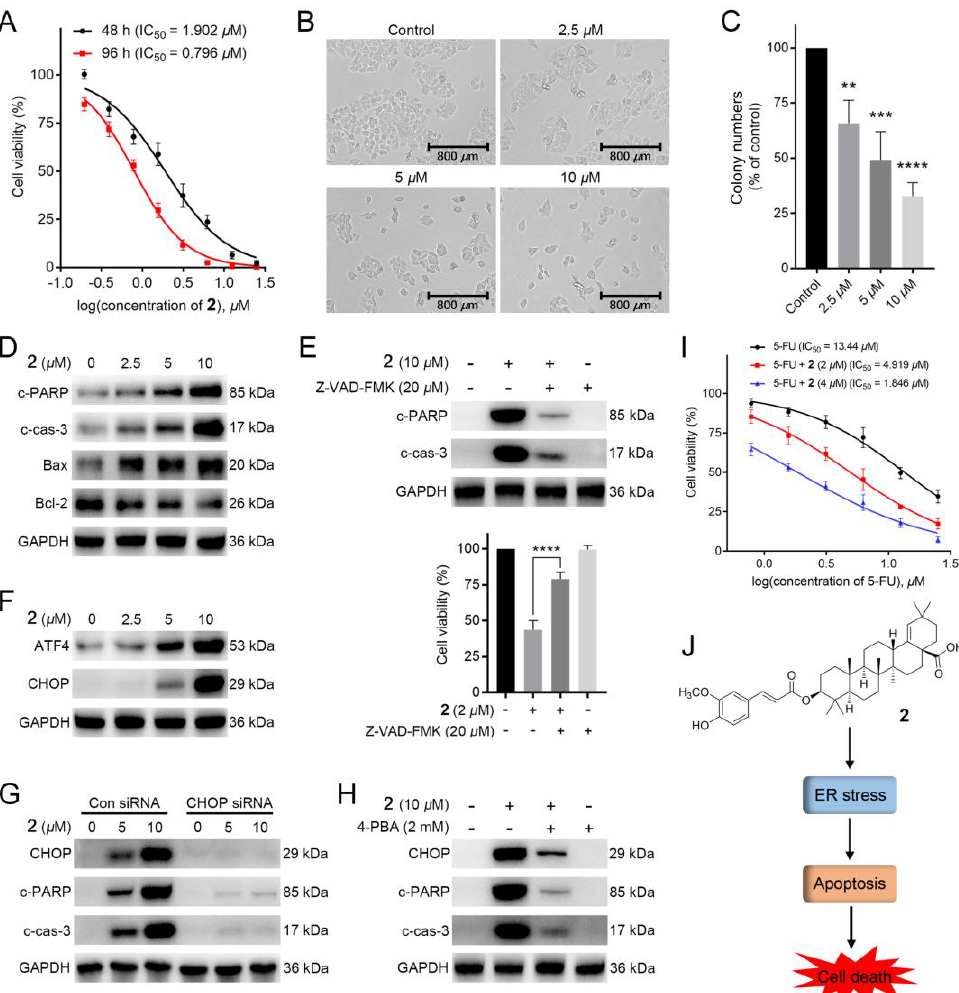
Figure 5. 2 exerted potent cytotoxic activity in colorectal cancer cells: ( A ) The anti-proliferative effects of 2 on HCT-116 cells. MTT assay was applied to determine the cell viability of HCT-116 cells treated with several concentrations of 2 for 48 and 96 h; ( B ) The cell morphology of HCT-116 cells with the administration of several concentrations (0, 2.5, 5, and 10 µ M) of 2 for 12 h; ( C ) The colony assay of HCT-116 cells with the administration of different concentrations (0, 2.5, 5, and 10 µ M) of 2 ; ( D ) Western blotting of the expressions of c-PARP, c-cas-3, Bax and Bcl-2 in HCT-116 cells. Cells were treated with or without several concentrations (2.5, 5, and 10 µ M) of 2 for 12 h; ( E ) Effects of apoptosis on 2 -induced cell death in HCT-116 cells. The expression levels of c-PARP and c-cas-3 in HCT-116 cells treated with 2 (10 µ M), Z-VAD-FMK (20 µ M), or both were measured by western blotting. MTT assay was conducted to determine the cell viability of HCT-116 cells with administration of Z-VAD-FMK (20 µ M) followed by 2 (2 µ M) for 12 h; ( F ) Western blotting analysis of key transcription factors (ATF4 and CHOP) in HCT-116 cells. Cells were added into several concentrations (0, 2.5, 5, and 10 µ M) of 2 for 12 h; ( G ) Western blotting analysis of the effect of CHOP knockdown on 2 -induced protein changes. Cells with or without CHOP knockdown were added into 2 (5 and 10 µ M) for 12h, respectively; ( H ) Western blot analysis of the effect of 4-PBA on 2 -induced proteins changes in HCT-116 cells. Cells with the pre-treatment of 4-PBA (2000 U/mL) were treated with 2 (10 µ M) for 12 h; ( I ) The anti-proliferative effects of 2 on the cytotoxicity of 5-FU in HCT-116 cells. Cells were treated with several doses of 5-FU with or without administration of 2 (2 and 4 µ M) for 48 h. Cell viability was tested using MTT assay; ( J ) Schematic illustration of the underlying mechanism of anticancer activity of 2 [ n = 3, ** p < 0.01, *** p < 0.001 and **** p < 0.0001 compared to the control